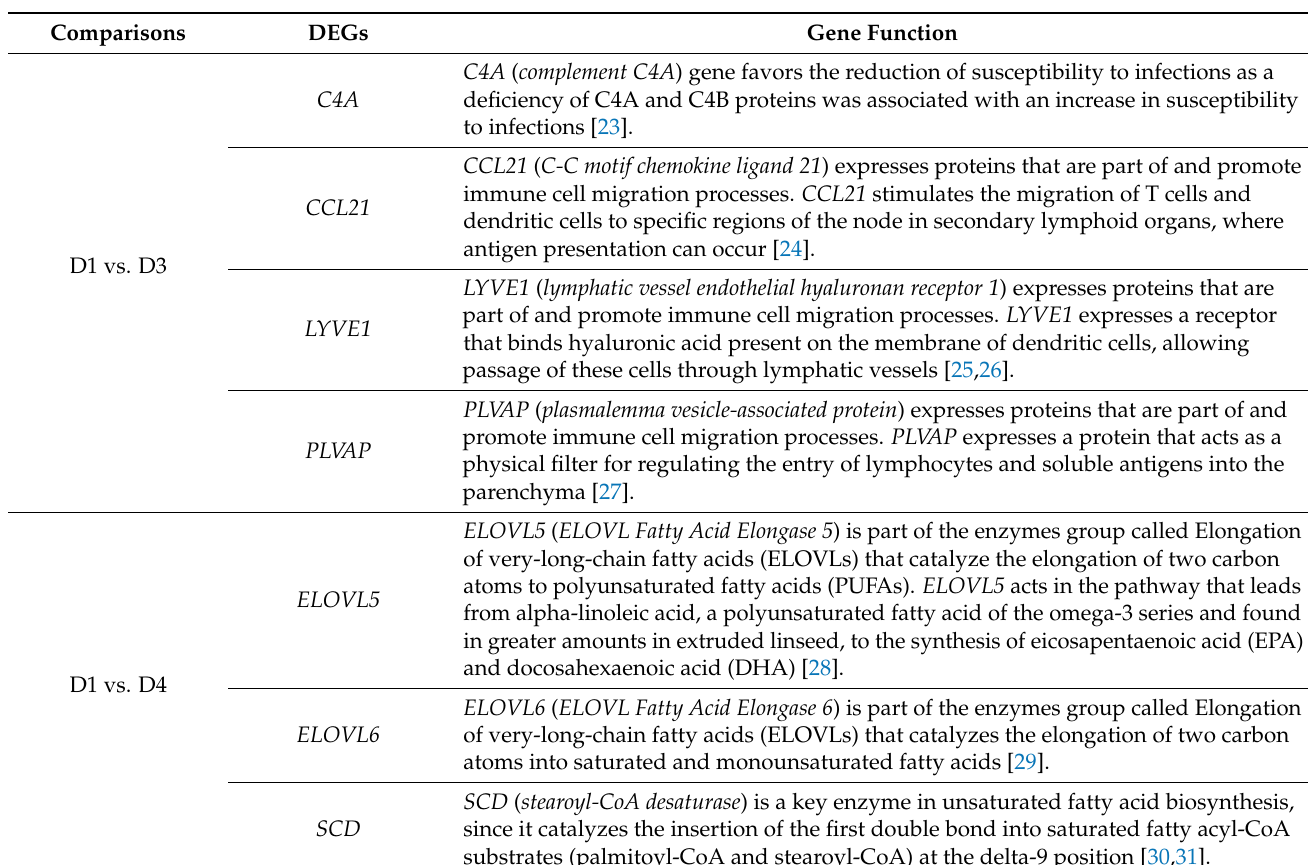
Table 4. Description of the functions of the most relevant differentially expressed genes (DEGs).